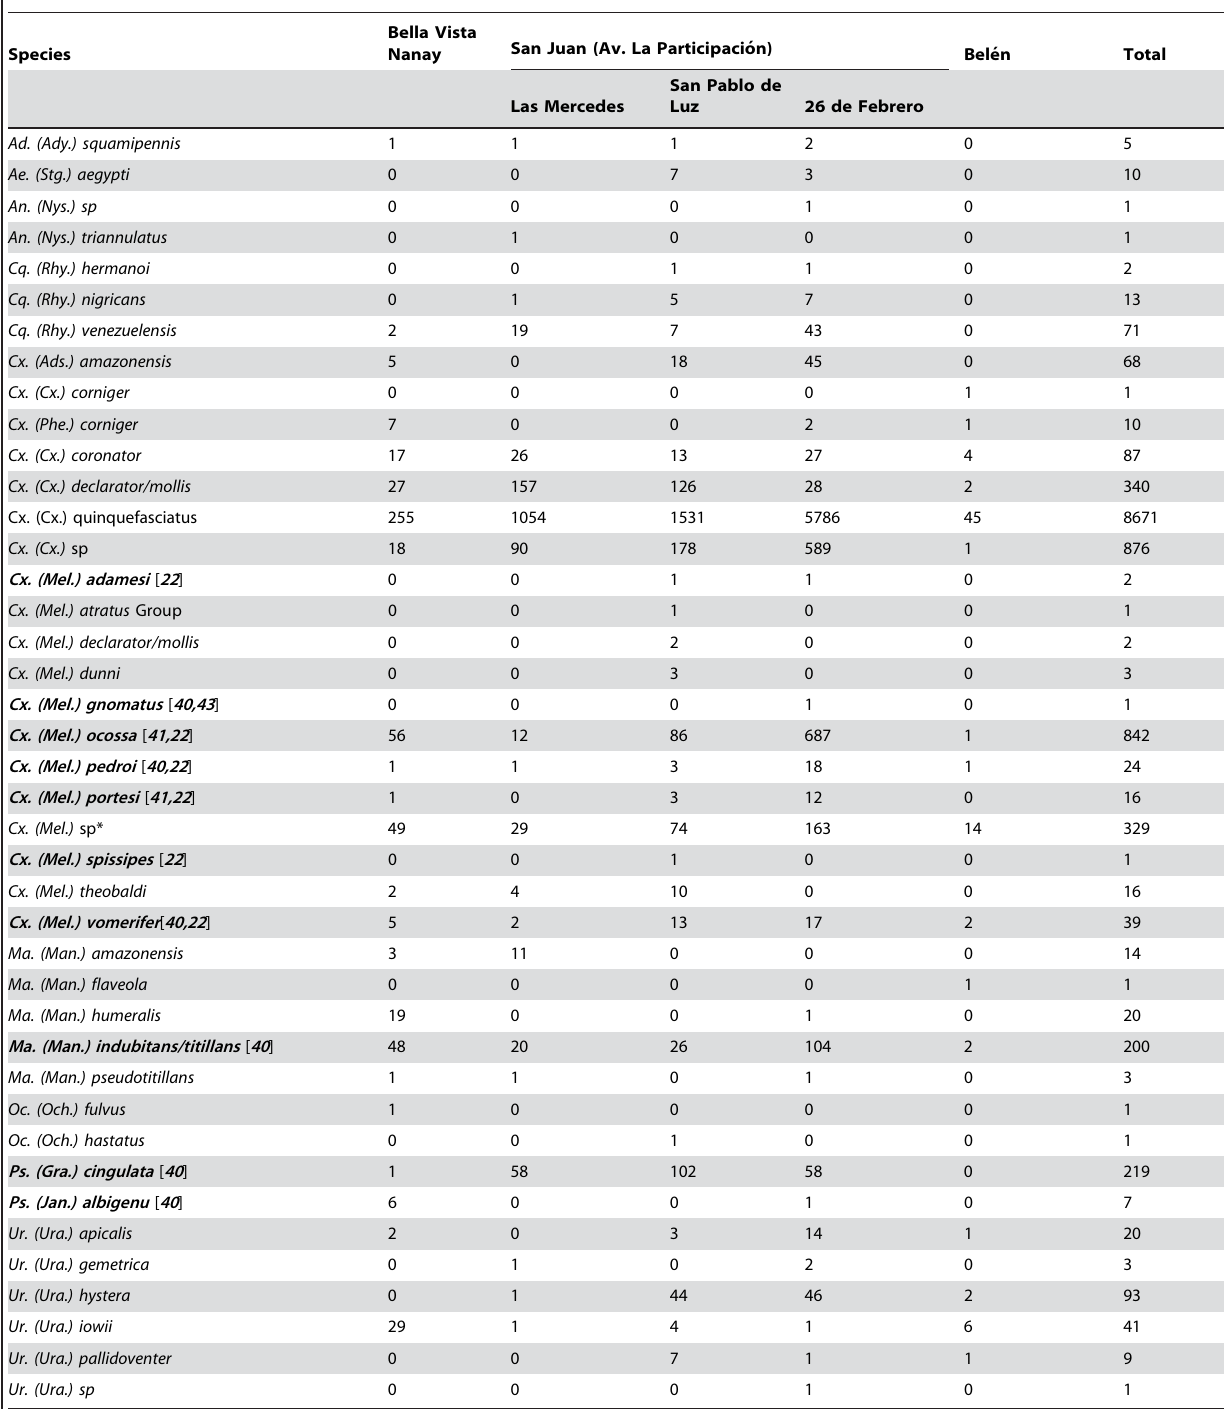
Table 8. Mosquitoes collected in CDC Light traps in neighborhoods with clinical cases of VEEV infection in 2006.